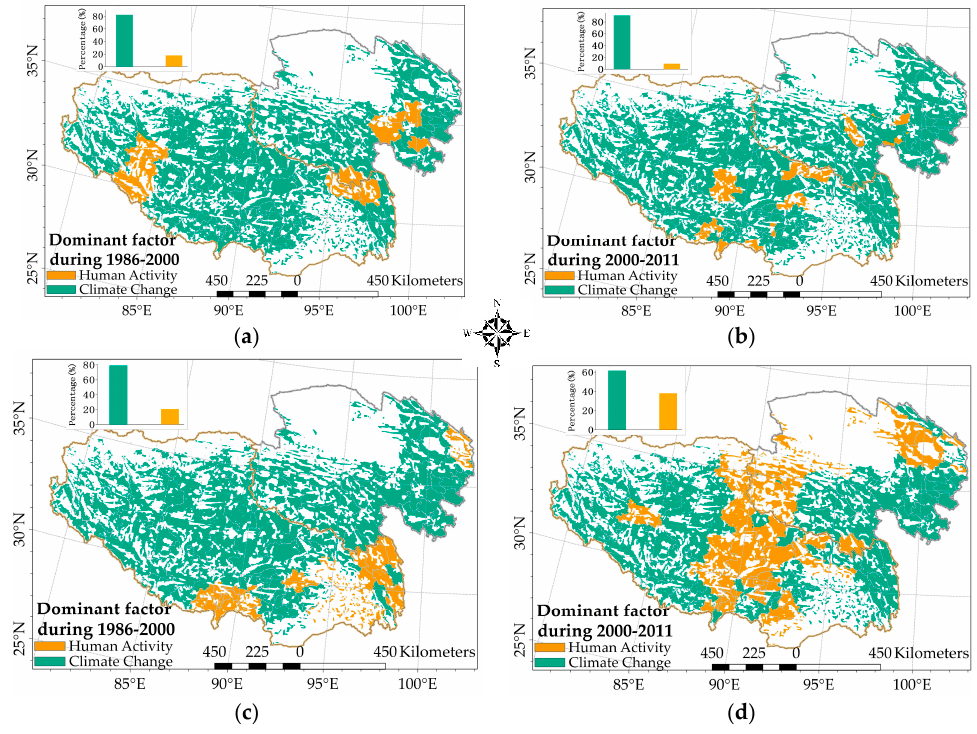
Figure 8. The dominant factors driving the dynamics of vegetation vigor across Qinghai-Tibet Plateau ( a , b ): Dominant driving factors during 1986–2000 and 2000–2011 as identified from statistical model; ( c , d ): Dominant driving factors during 1986–2000 and 2000–2011 with higher variation explained via ecosystem production model. Bar charts in upper-left corner show the percentage of total area impacted by driving factors. Note: Contribution of climate change in ( a , b ) to vegetation vigor = ∑ GST + GSP contributions.